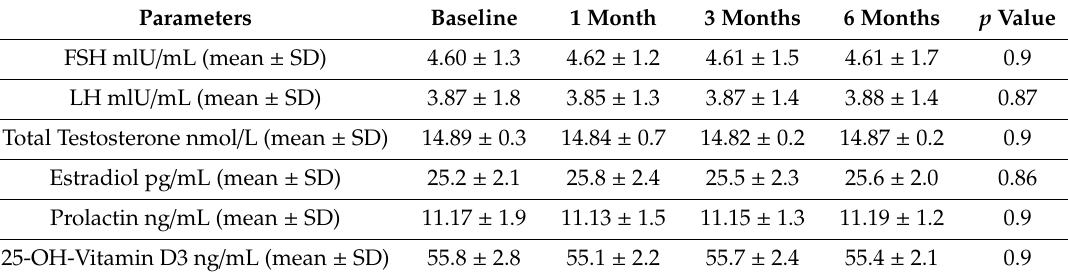
Table 3. Hormonal evaluation at baseline 1, 3, and 6 months after